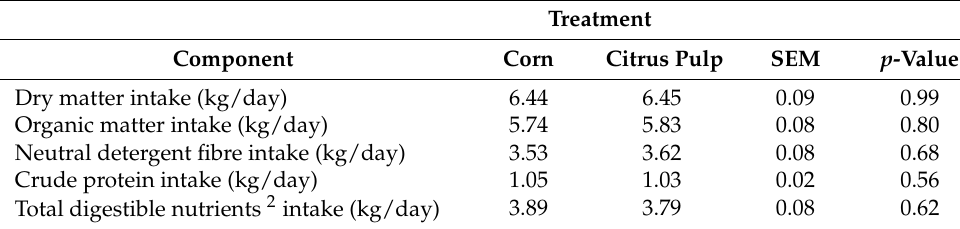
Table 3. Nutrient intake of growing rumen cannulated Nellore steers grazing Uruchloa brizantha cv Marandu pastures and fed corn or citrus pulp-based supplements during the wet-dry transition period 1 .